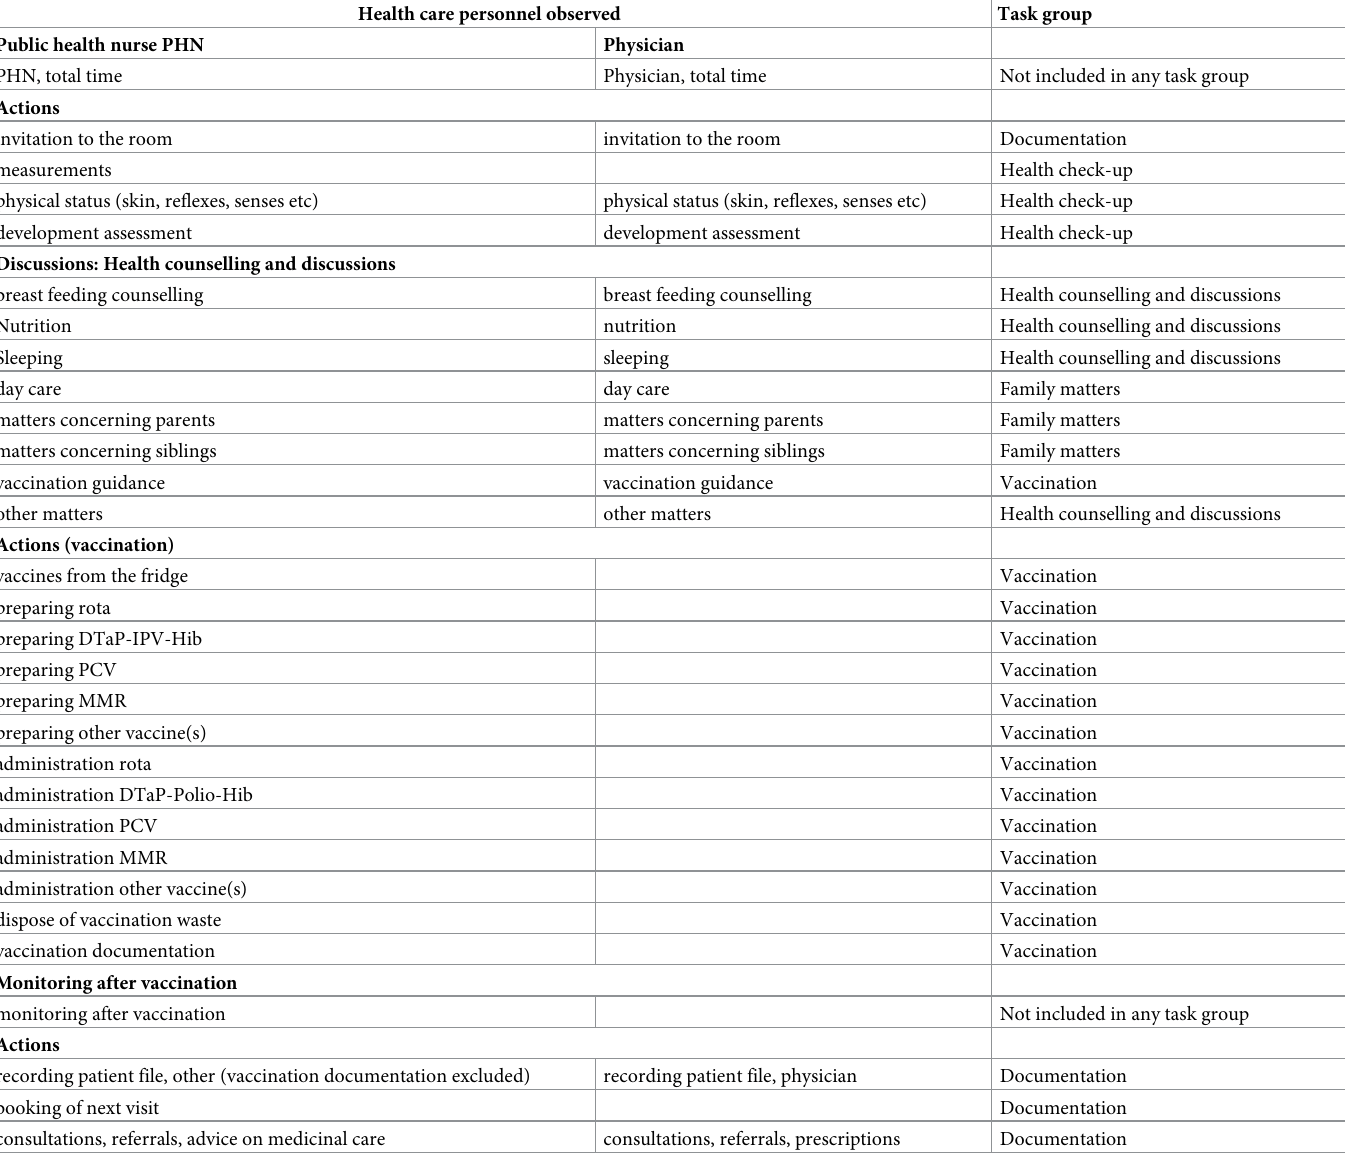
Table 1. Observed tasks for which times were